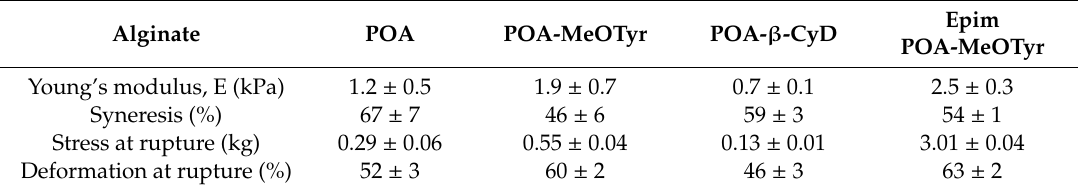
Table 2. Mechanical properties of Ca-saturated alginate hydrogels (1.0% w / v ) of modified material solely, based on 8% oxidized stipe alginate (POA), grafted with MeOTyr (POA-MeOTyr), β -CyD (POA- β -CyD) or epimerized alginate grafted with MeOTyr (EpimPOA-MeOTyr). Alginate POA POA-MeOTyr POA- β -CyD Epim POA-MeOTyr Young’s modulus, E (kPa) 1.2 ± 0.5 1.9 ± 0.7 0.7 ± 0.1 2.5 ± 0.3 Syneresis (%) 67 ± 7 46 ± 6 59 ± 3 54 ± 1 Stress at rupture (kg) 0.29 ± 0.06 0.55 ± 0.04 0.13 ± 0.01 3.01 ± 0.04 Deformation at rupture (%) 52 ± 3 60 ± 2 46 ± 3 63 ± 2